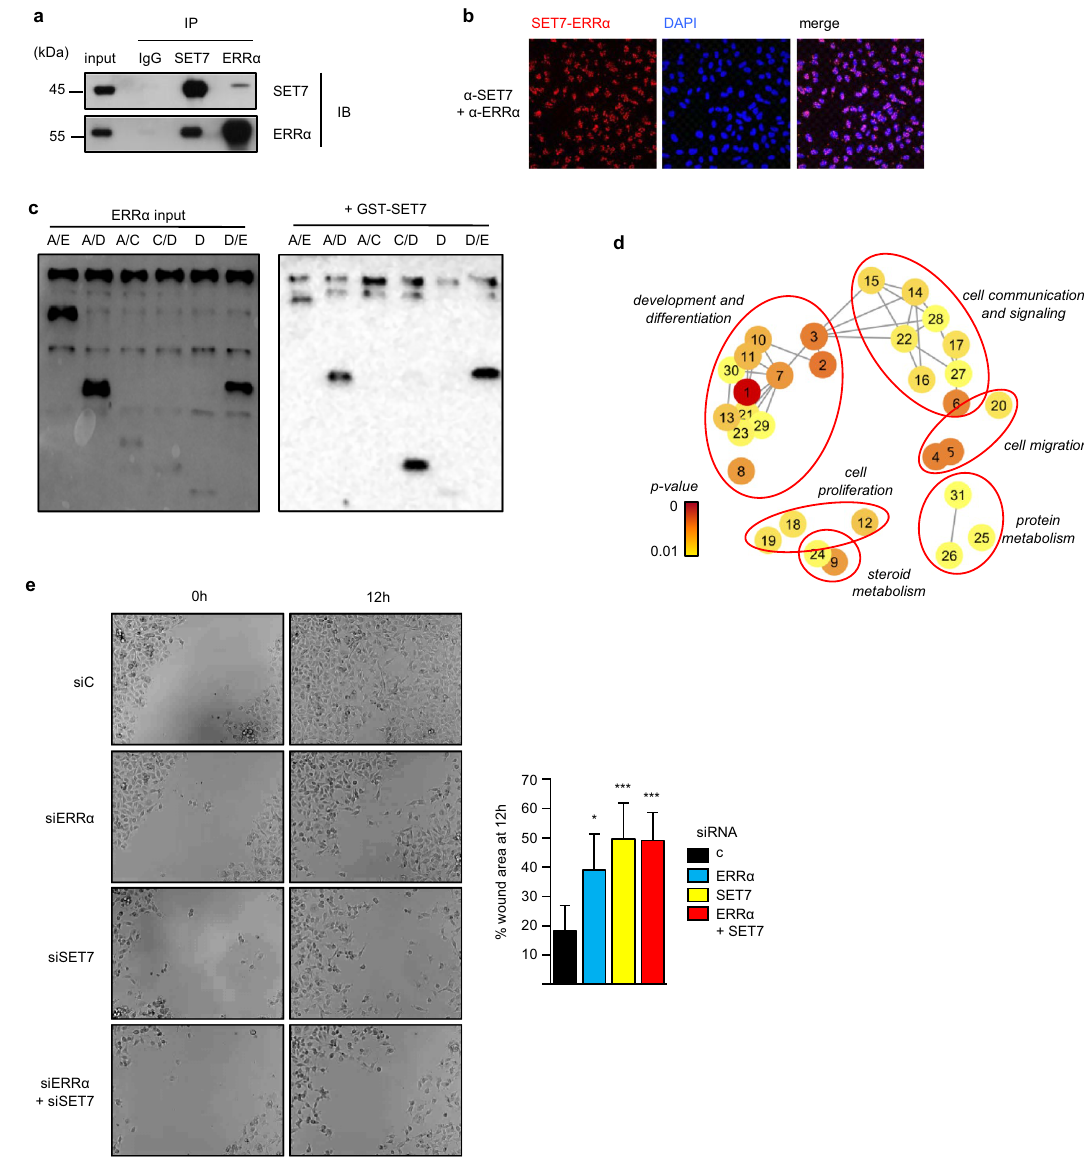
Figure 7. SET7 and ERRα are involved in cell invasion. ( a) Co-immunoprecipitation of endogenous proteins in MDA-MB-231 cells with anti-SET7 or anti-ERRα antibodies and rabbit IgG used as a control. IP: immunoprecipitation, IB: immunoblotting. Proximity ligation assay (PLA) used to detect interaction of endogenous SET7 and ERRα in MDA-MB231 cells. Cells were counterstained with DAPI. See also Figure S5-c for PLA controls. ( c) Indicated ERRα moiety were produced in vitro and identified on the left panel. Same ERRα moiety were hybridized on GST-SET7. ( d) ERRα/SET7 regulated genes were analyzed by Gene Ontology (GO). After elimination of redundant terms, network of enriched GO terms obtained by REVIGO software (grouped according to semantic similarity) is shown. Colors indicate p -value. GO terms are coded by number (see Figure S6-a for correspondence with GO terms). (e) Confluent layers of MDA-MB-231 cells transfected with the indicated siRNA were scratch-wounded, phase contrast microphotographs were taken at the indicated times after wounding (left panels). Quantification (right panel) is displayed as percentage of remaining cell-free space at 12 h. Data are means of three independent experiments (3 fields per experiment) + /- sem. Significance was evaluated by t-test, with *** p < 0.005, * p < 0.05. Uncropped Western blot images are presented on Figure